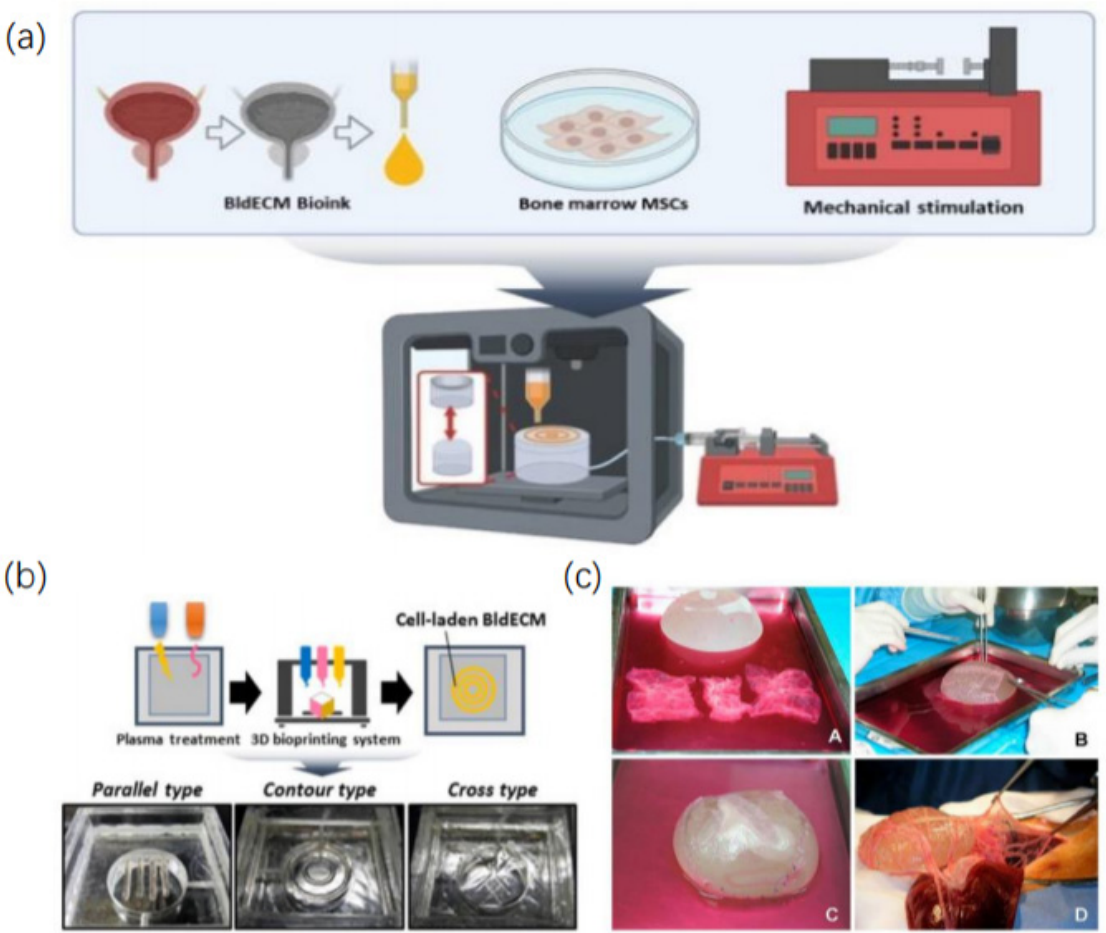
Figure 4. ( a ) Schematic diagram of in vitro 3D-bioprinted bladder model system. Reprinted with permission from ref. [98]; ( b ) Process of 3D-bioprinted bladder of different shapes. Reprinted with permission from ref. [98]; ( c ) Procedure of 3D bioprinting and implantation of bladder bioreactor in vivo. Reprinted with permission from ref. [101].